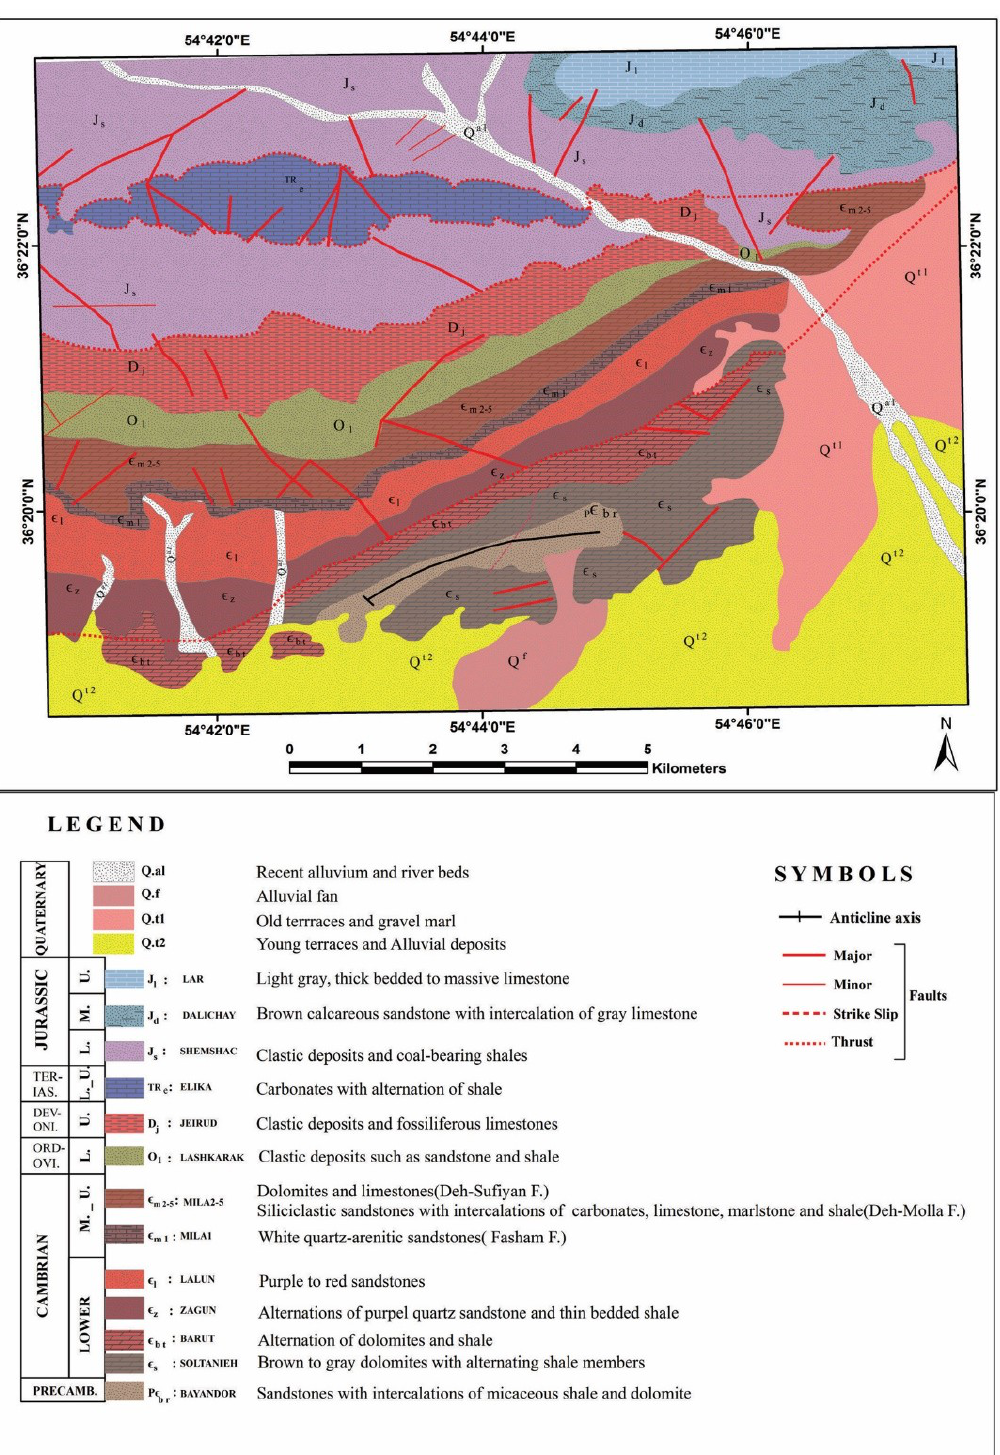
Figure 2. Geological map of the Deh-Molla illustrates the sedimentary Formations in the area of study. The Fasham Formation is a newly introduced rock unit by Geyer et al. [25]. Type section of this rock unit is also located in the Deh-Molla section. Fasham Formation consists of 60–100 m of white quartz-arenitic sandstones [28]. This stratigraphic shift is a consequence of an unconformity recognized at the base of this quartzarenite unit. It is traditionally called Mila Formation sensu [26], which was subdivided into five members. Mila Group comprises Fasham, Deh-Sufyian, Deh-Molla, and